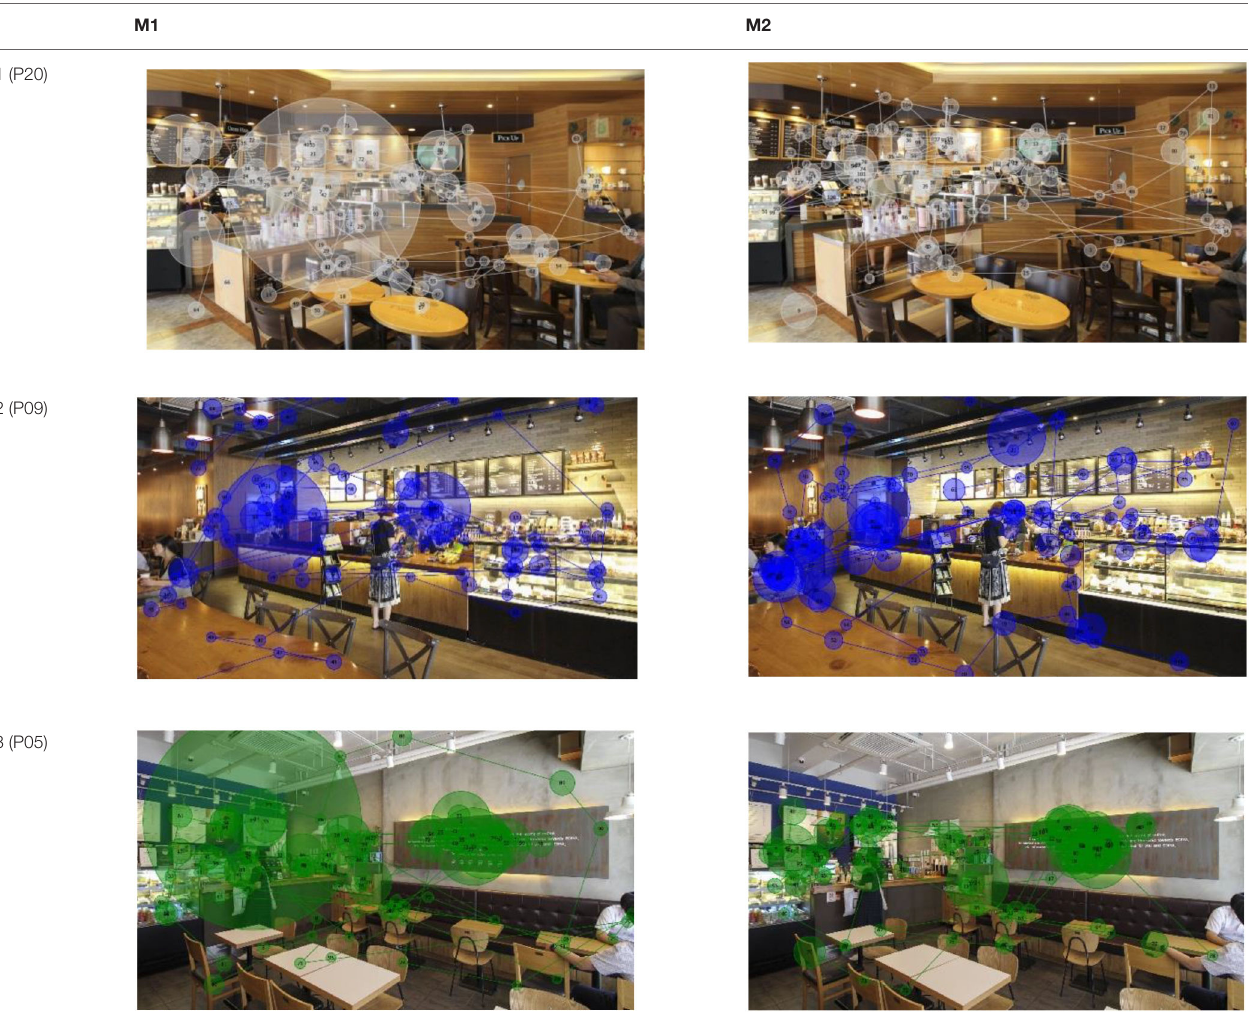
TABLE 5 | Gaze plots by music (Participants #20, #09, and #05